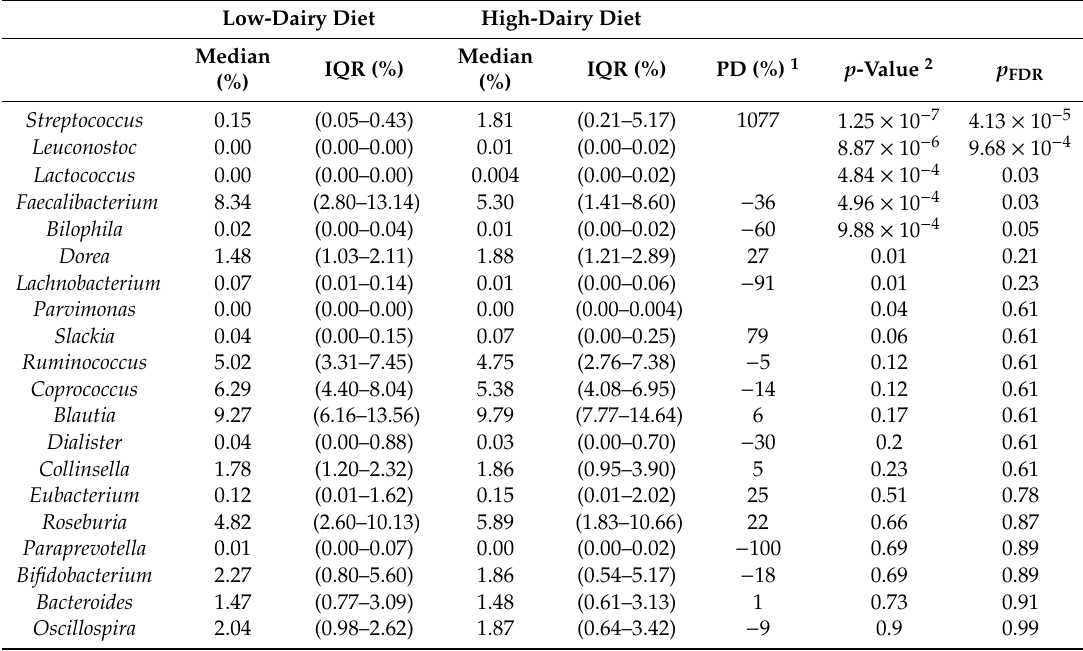
Table 3. The relative abundance of di ff erent bacteria on taxonomic genus